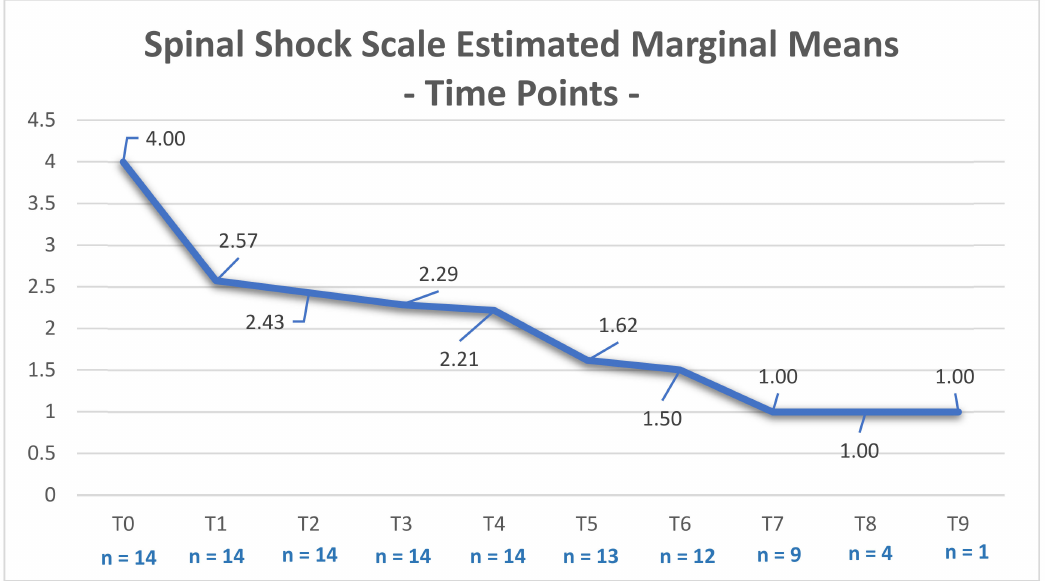
Figure 10. Evolution of the spinal shock scale-estimated marginal means in the study group through- out the intensive neurorehabilitation process. Y -axis: Spinal shock scale score; T0 (day 0); T1 (day 1);